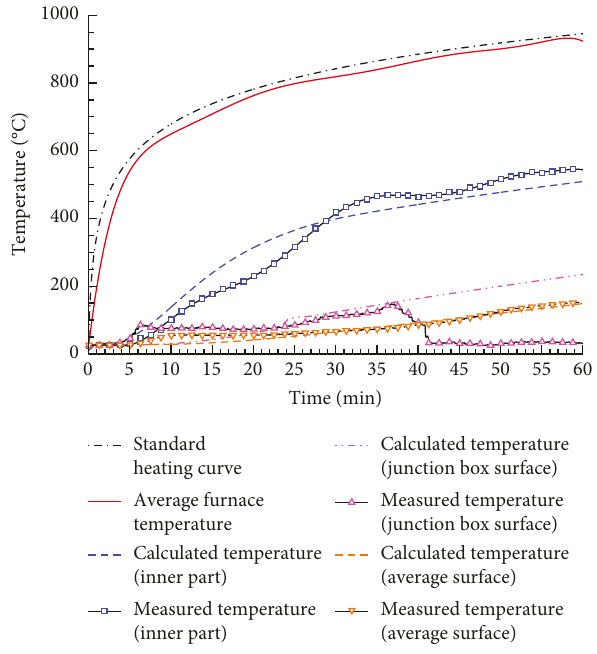
Figure 21: Measured temperatures compared to the calculated values in Test 3.